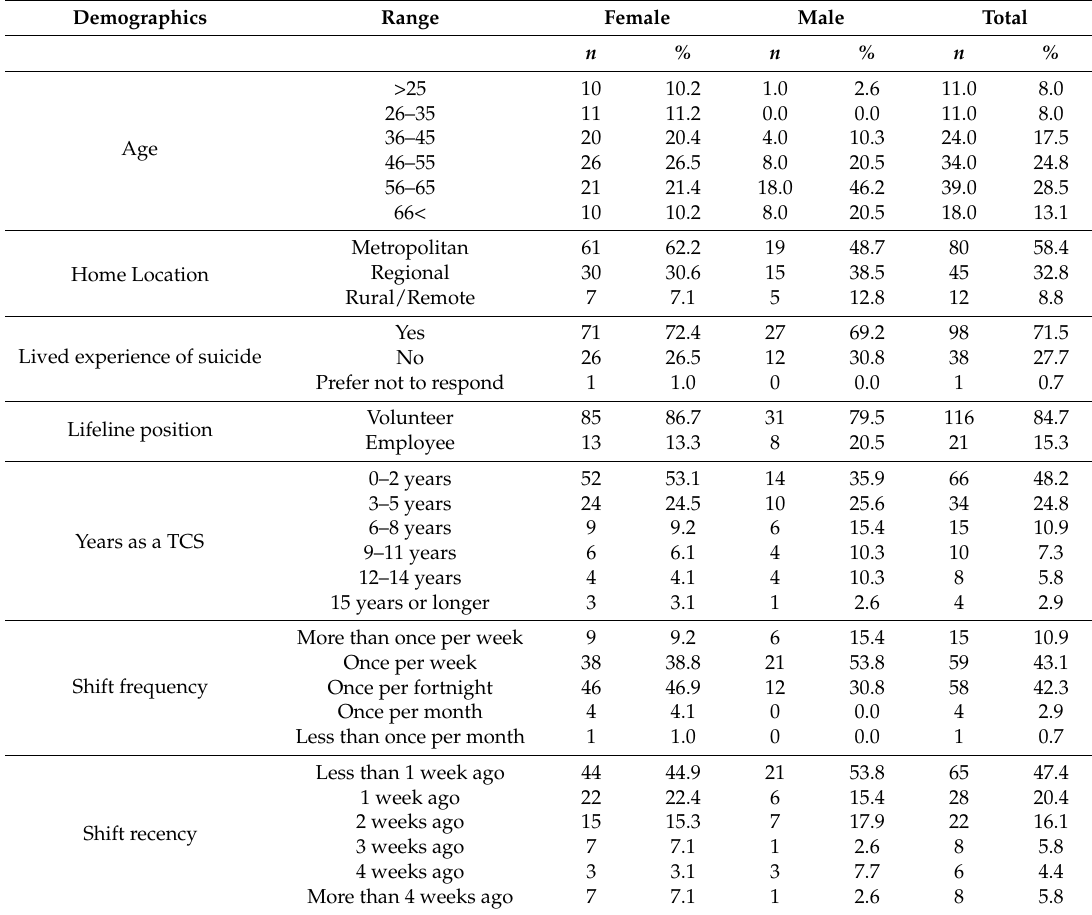
Table 1. Demographics of Participants split by female ( n = 98) and male ( n = 39) telephone crisis-line workers